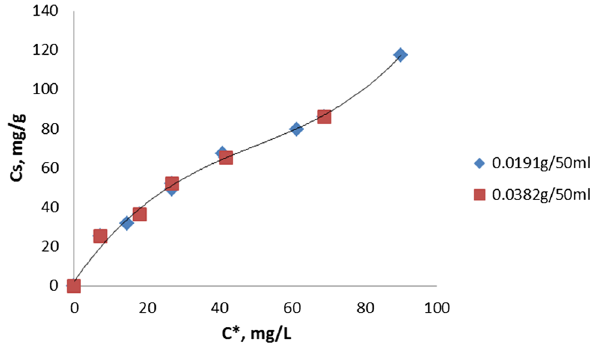
Fig. 4 Effect of biomass dosage (pH = 5; temperature 298 K)